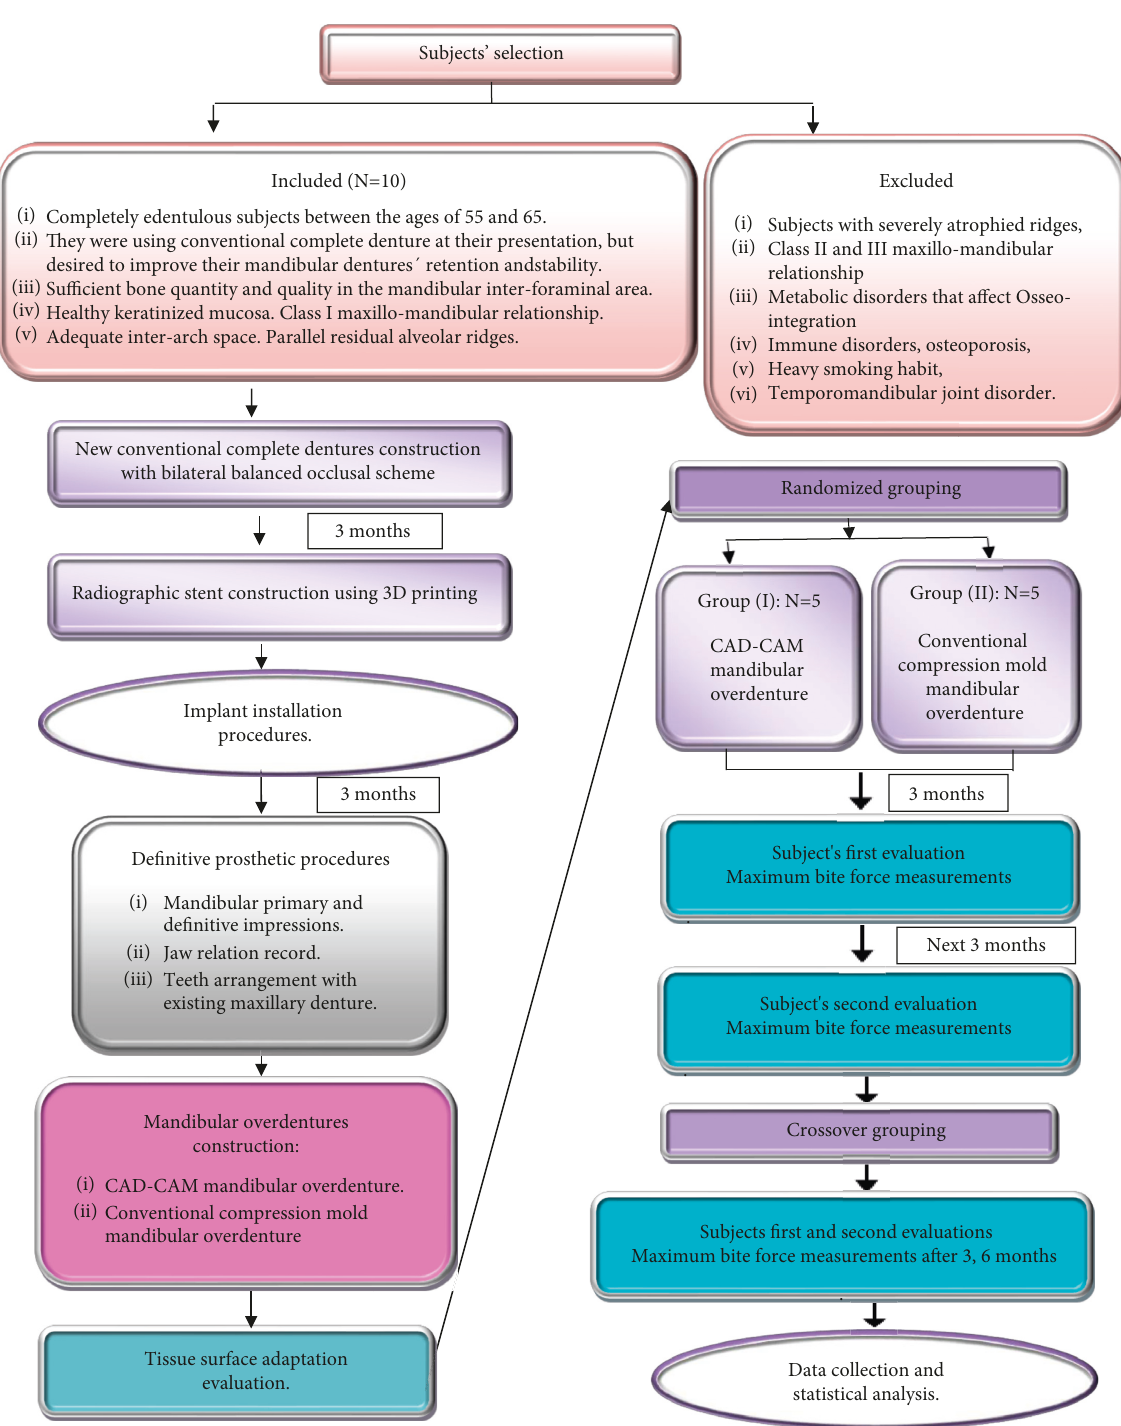
Figure 1: Subjects’ selection, treatment procedures, and subjects’